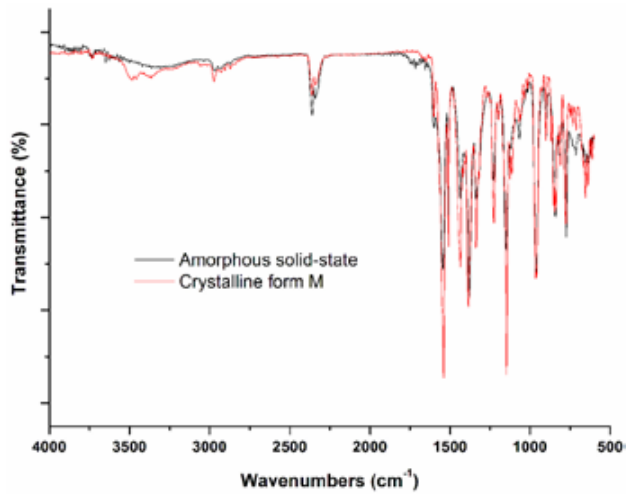
FIGURE 4 - IR spectra of ROSC in amorphous solid-state and crystalline form